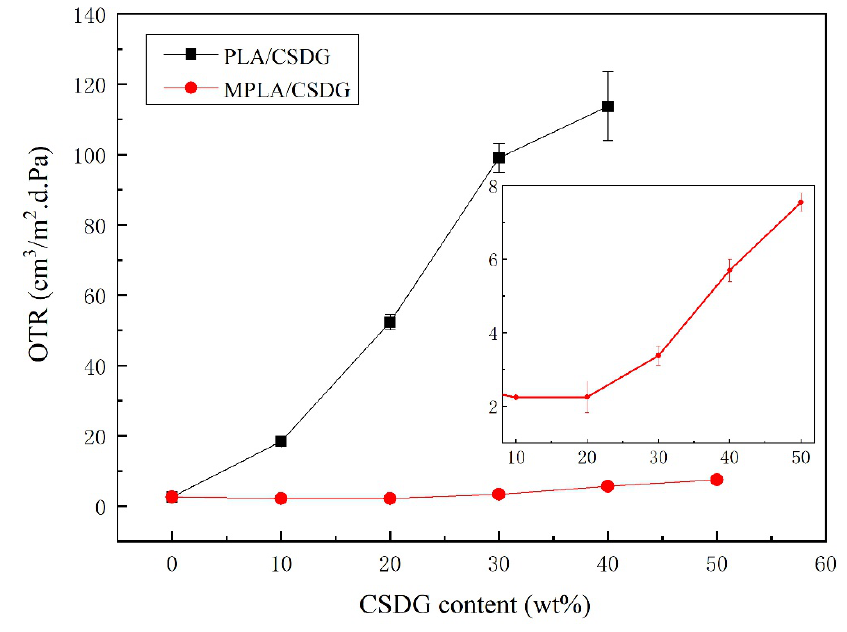
Figure 9. Oxygen barrier properties of PLA/CSDG and MPLA/CSDG composites.